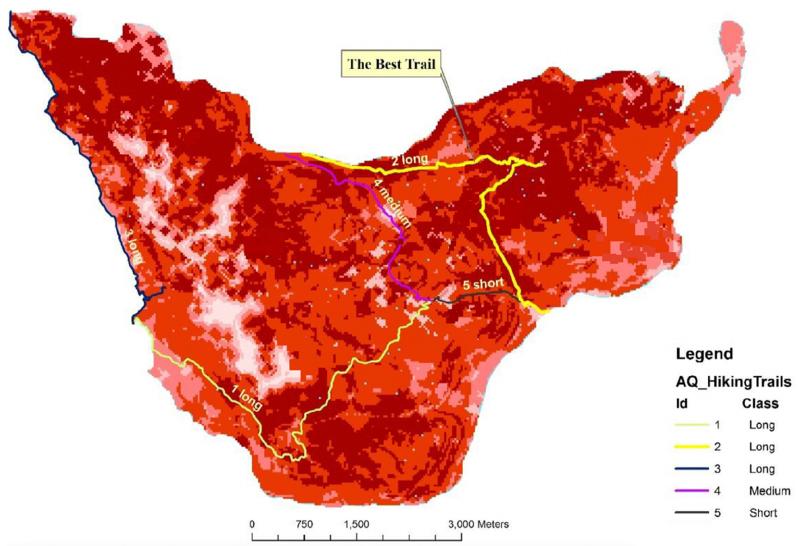
Figure 9. The best tourism hiking trails in Abu Qubies protected area based on the valuation of ecosystem services (use value—non-use value). Table 3. Ranking of the tourism hiking trails in Abu Qubies based on ecosystem services values.